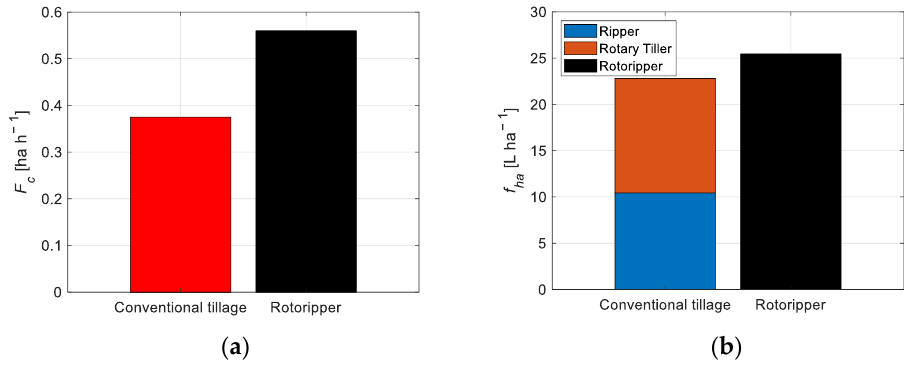
Figure 5. Mean values of operational and environmental indexes F c ( a ) and f ha ( b ).